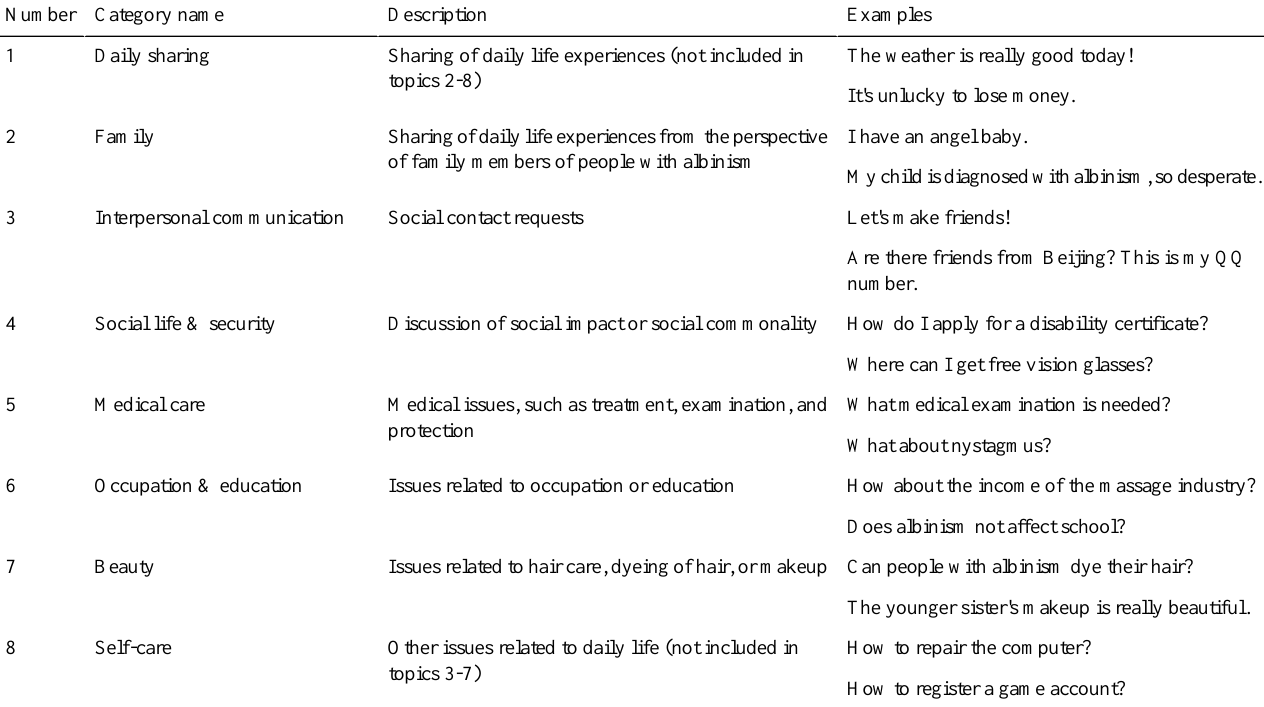
Table 2. The resulting 8 categories for the posts about albinism in the online community. ExamplesDescriptionCategory